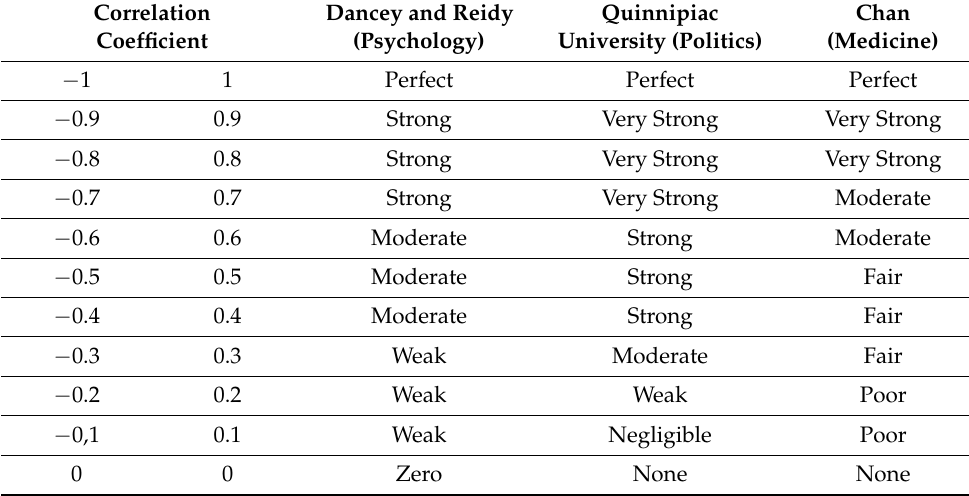
Table 1. Interpretation of the Pearson’s and Spearman correlation